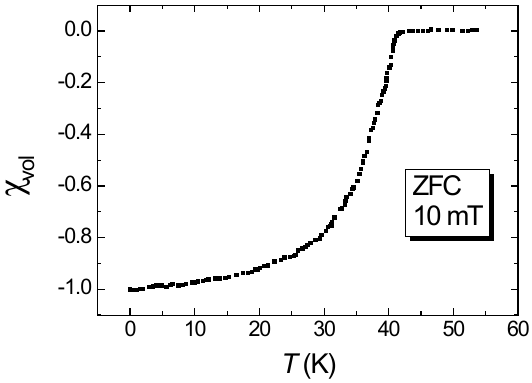
Figure 1. DC volume susceptibility, χ vol , as function of temperature measured in a zero-field cooled (ZFC) condition (applied field 10 mT).